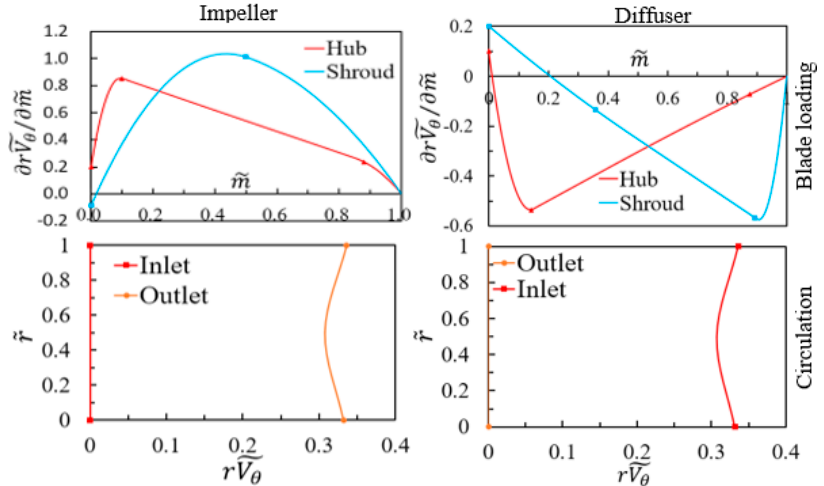
Figure 11. Blade loading distribution and circulation distribution of optimized impeller and dif- fuser.